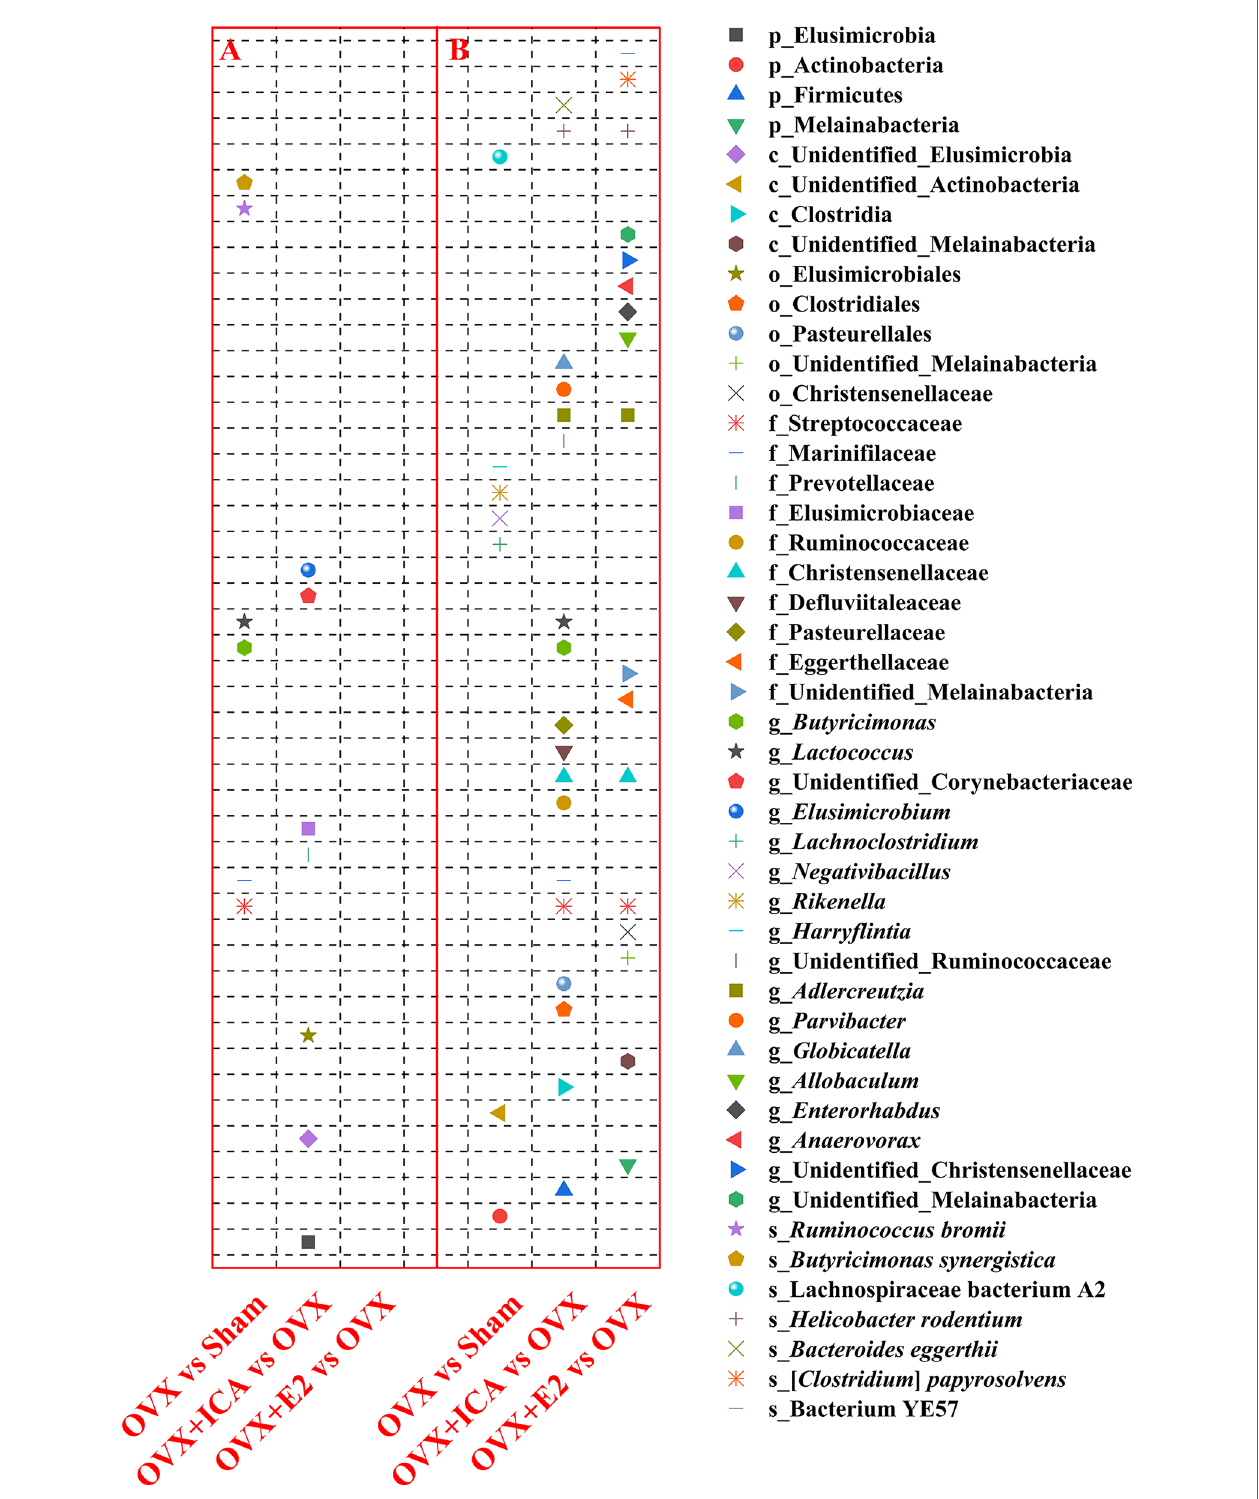
FIGURE 5 | Therapeutic effects of different treatments on the GM at different taxonomic levels by signi fi cant up-regulation (A) and down-regulation (B) between paired treatments (n = 10). The statistical analysis was performed by t -test at p = 0.05 using GraphPad Prism for Windows (Version 6.01,